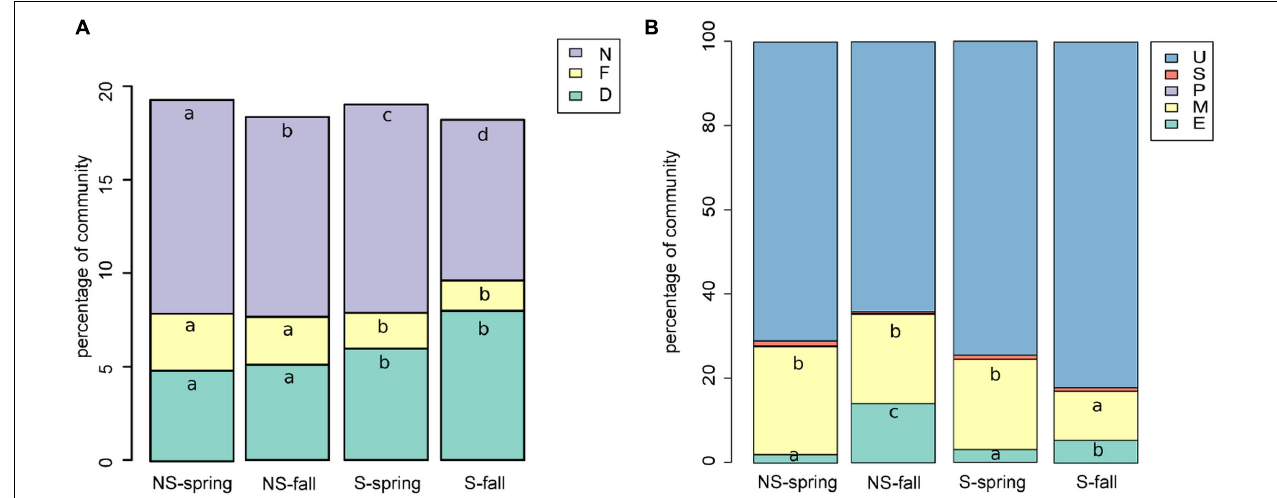
FIGURE 5 | Functional classification of (A) bacterial sequences: shares of bacterial functional groups potentially involved in nitrogen cycling, D, denitrifying; N, nitrifying; NF, nitrogen-fixing (A) ; (B) fungal sequences, E, endophytic; M, mycorrhizae forming; P, parasitic/pathogenic; S, saprophytic; U, unknown/unclassifiable (B) . Classification results were added to the OTU table and graphs were prepared and Kruskal–Wallis tests were